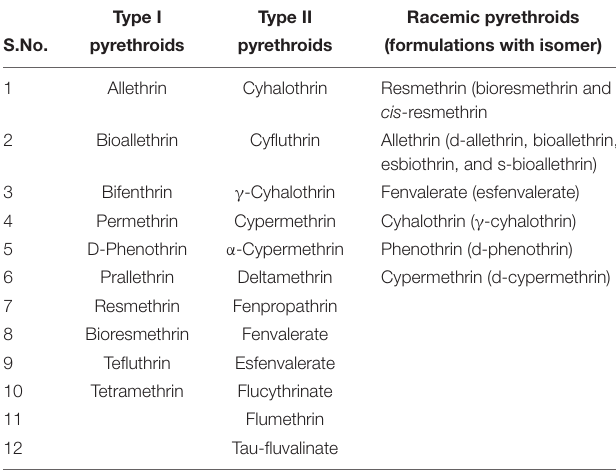
TABLE 1 | Brief classification of indoor and agricultural